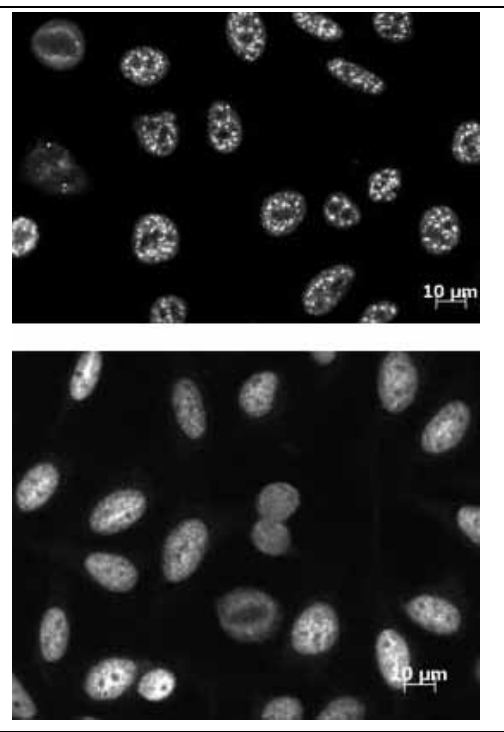
figurE 3 – Nuclear coarse speckled pattern in samples with anti-U1 RNP antibodies Upper panel: expected and observed pattern on slides A-G. Lower panel: discrepant fine speckled pattern observed on slide H. RNP: